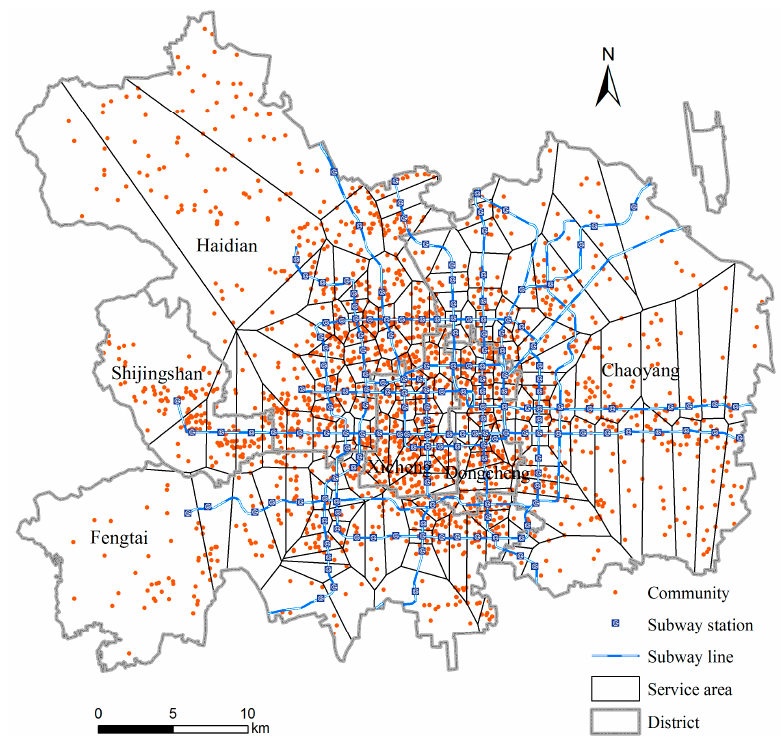
Figure 1. Catchment areas of subway stations in the central area of Beijing. Table 1. Data used in this